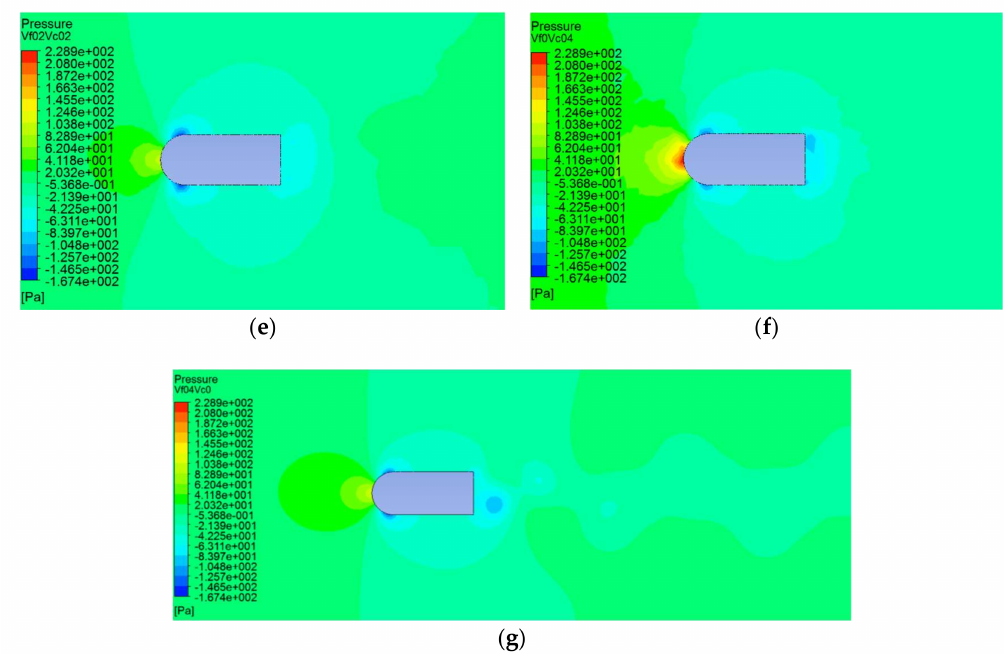
Figure 5. Static pressure distributions in di ff erent simulation conditions. ( a ) V f = 0.1 m / s and V c = 0.2 m / s; ( b ) V f = 0.2 m / s and V c = 0.1 m / s; ( c ) V f = 0 m / s and V c = 0.3 m / s; ( d ) V f = 0.3 m / s and V c = 0 m / s; ( e ) V f = 0.2 m / s and V c = 0.2 m / s; ( f ) V f = 0 m / s and V c = 0.4 m / s; ( g ) V f = 0.4 m / s and V c = 0 m / s.